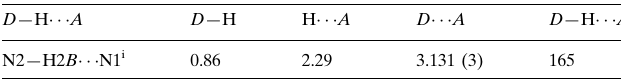
Hydrogen-bond geometry (A˚ , (cid:2)